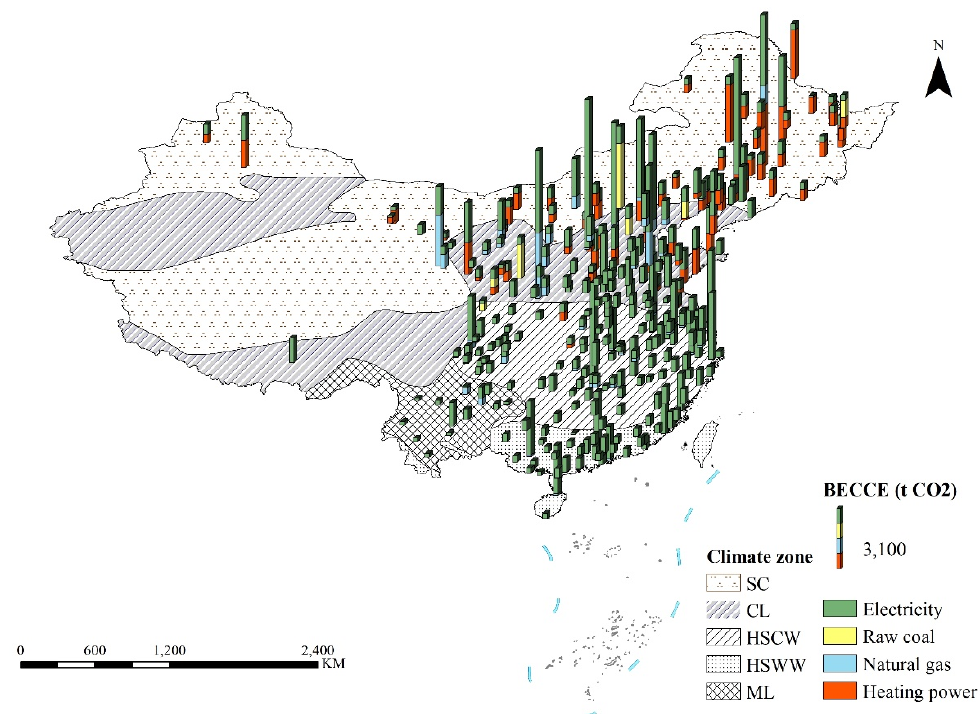
Figure 6. BECCE stacking diagram of 288 PBOC buildings. The higher histogram means a greater amount of BECCE. Histograms with different colors represent the BECCE generated by corresponding energy.